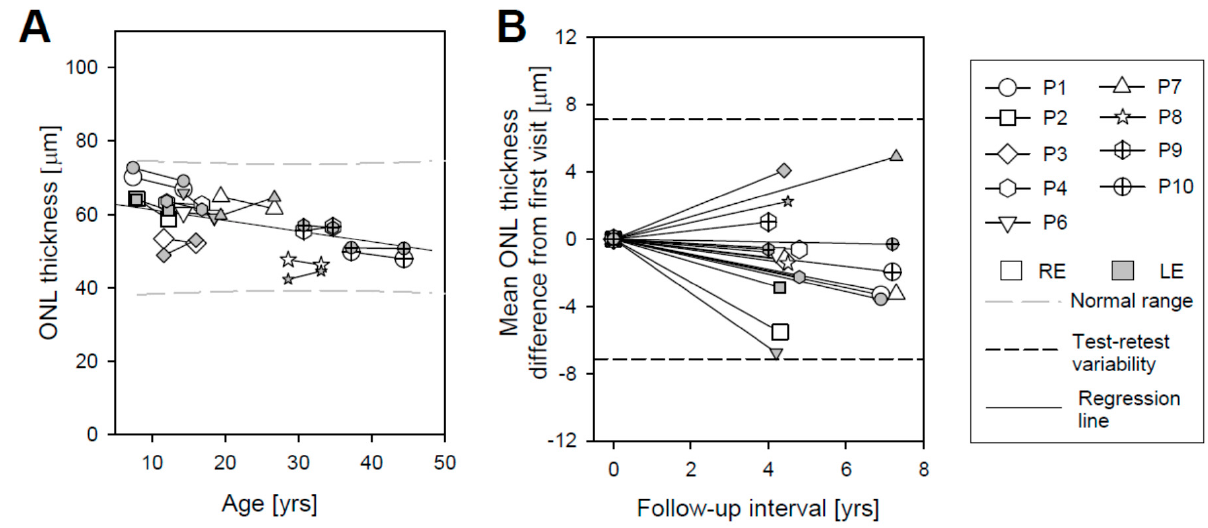
Figure 5. Superior retinal ONL measurements in GUCY2D –LCA patients at two visits. ( A ) ONL thickness as a function of patient age. Solid lines connect serial data. Black long dashed lines represent the range of normal ONL thickness for comparison [19]. The gray medium dashed line is the regression line. ( B ) Differences in average ONL thickness from the first visit versus follow-up interval. Short dashed lines show test–retest variability.